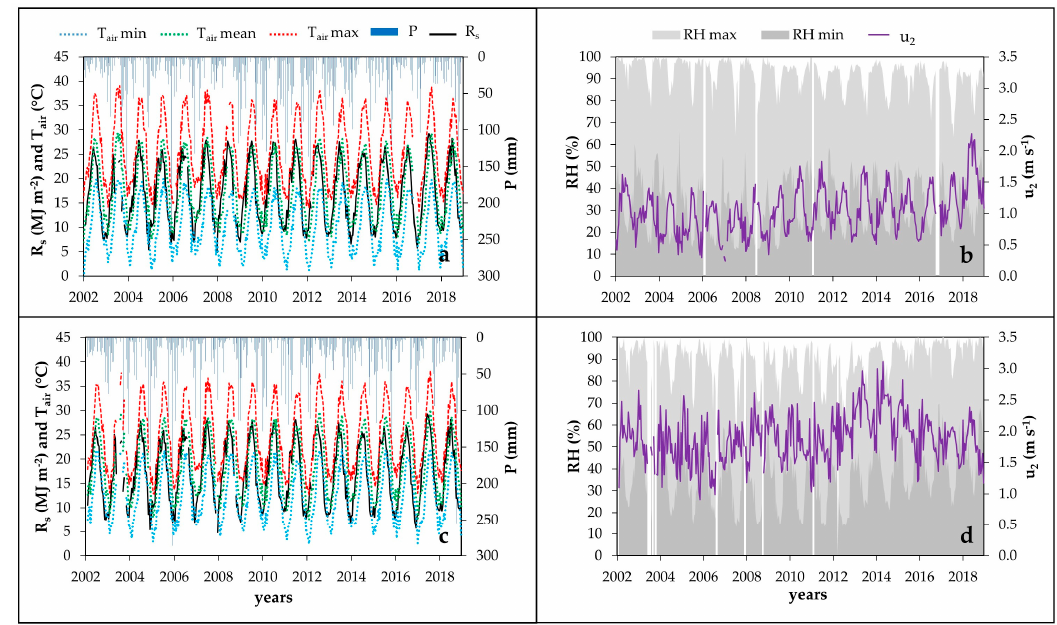
Figure 2. Sixteen-day averages of meteorological data (T air , R s , u 2 , P, RH) recorded at ( a , b ) S234 and ( c , d ) S292 weather stations during the available 2002–2018.